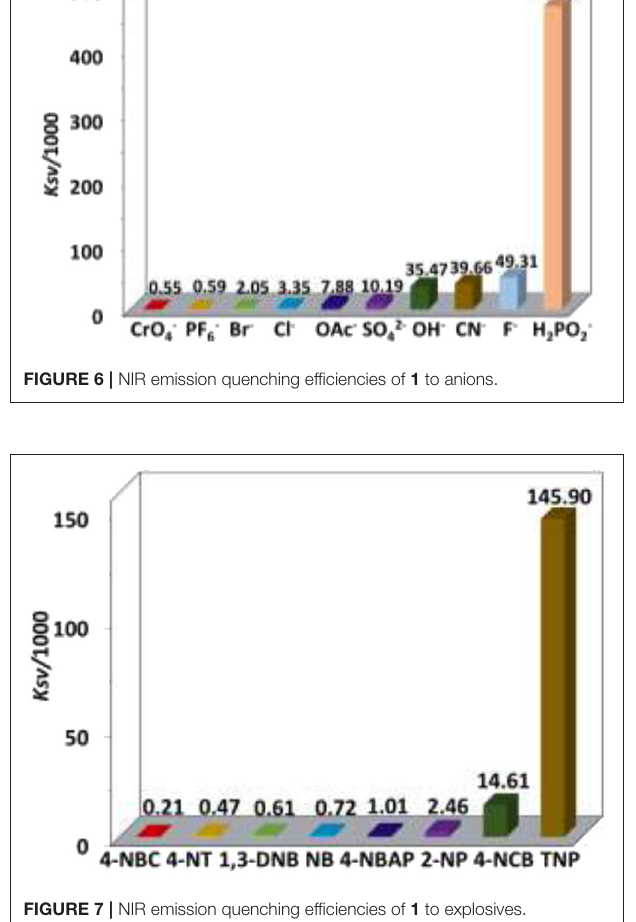
FIGURE 7 | NIR emission quenching efficiencies of 1 to explosives.